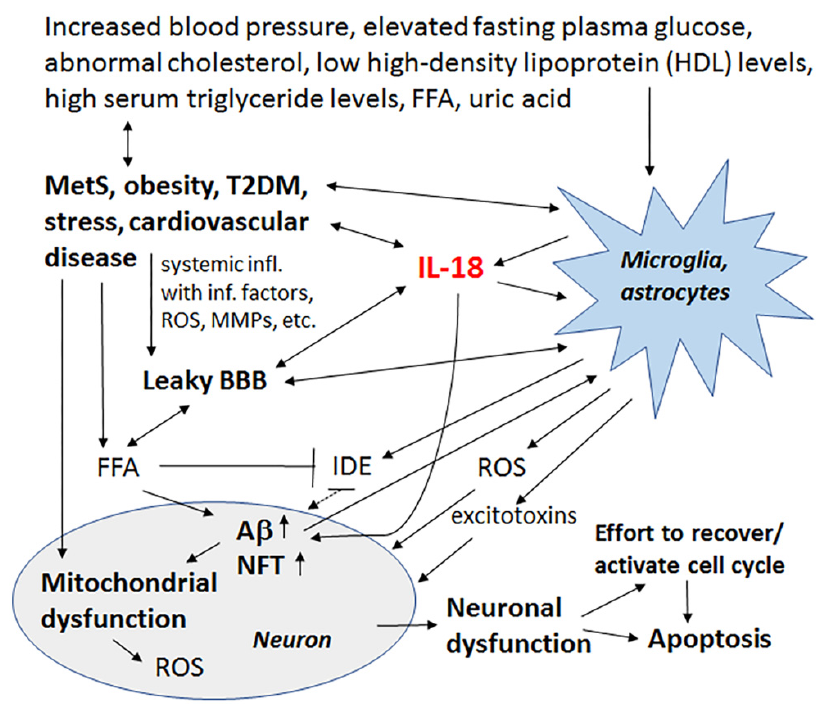
Figure 7. MetS and its role in neurodegeneration. IL-18 and OS, linked to AD and conditions that are associated to MetS, have multiple impacts on targets related to these conditions. Further, hallmarks of MetS have multiple harmful influences on microglia, astrocytes and neurons, which can lead to increase in A β production and NFT formation, and eventually, neuronal loss. Crucial players in this process can be IL-18 and ROS. However, inflammatory changes caused by MetS are often called metaflamation, which is a feverless inflammation. The term metaflamation also draws intention to multiple environmental and lifestyle issues, which is mainly generated by an excess of nutrients and metabolic tissue-driven cytokines. The chronic low grade inflammation often causes fatigue, cognitive impairment, sleep alterations, chronic pain and depression, frequently evident in AD as well as in MetS and related disorders.